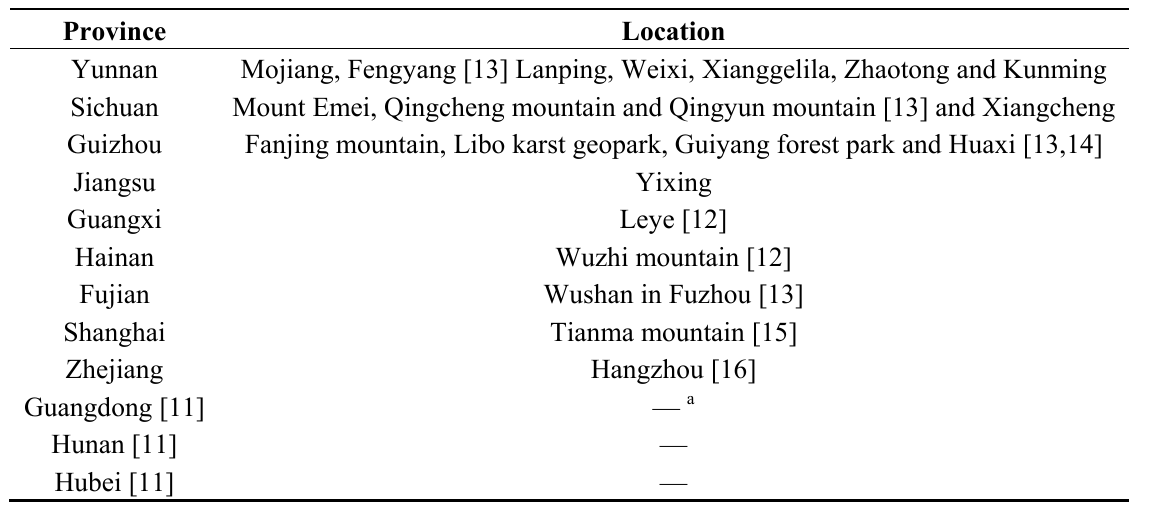
Table 1. Distribution of C. cicadae in